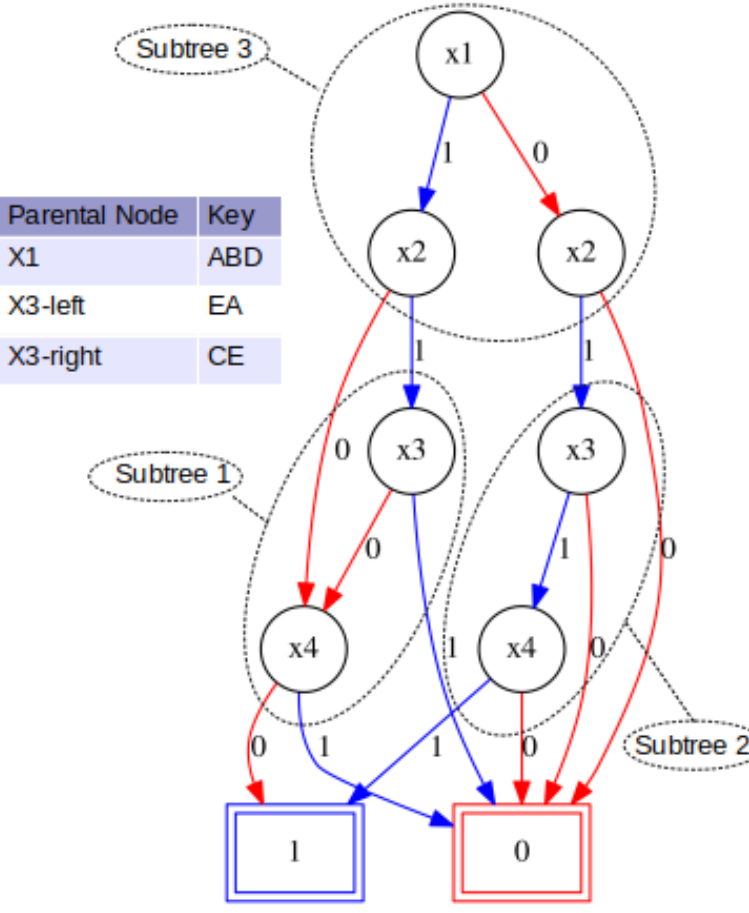
Figure 6. BDD representation of the Boolean function f ( x ) = x 1 x 2 x 3 x 4 + x 1 x 2 x 3 x 4 + x 1 x 2 x 3 x 4 + x 1 x 2 x 3 x 4 , where three subtrees are investigated and the construction of their suitable hash keys was performed as long as their parental nodes were identified.